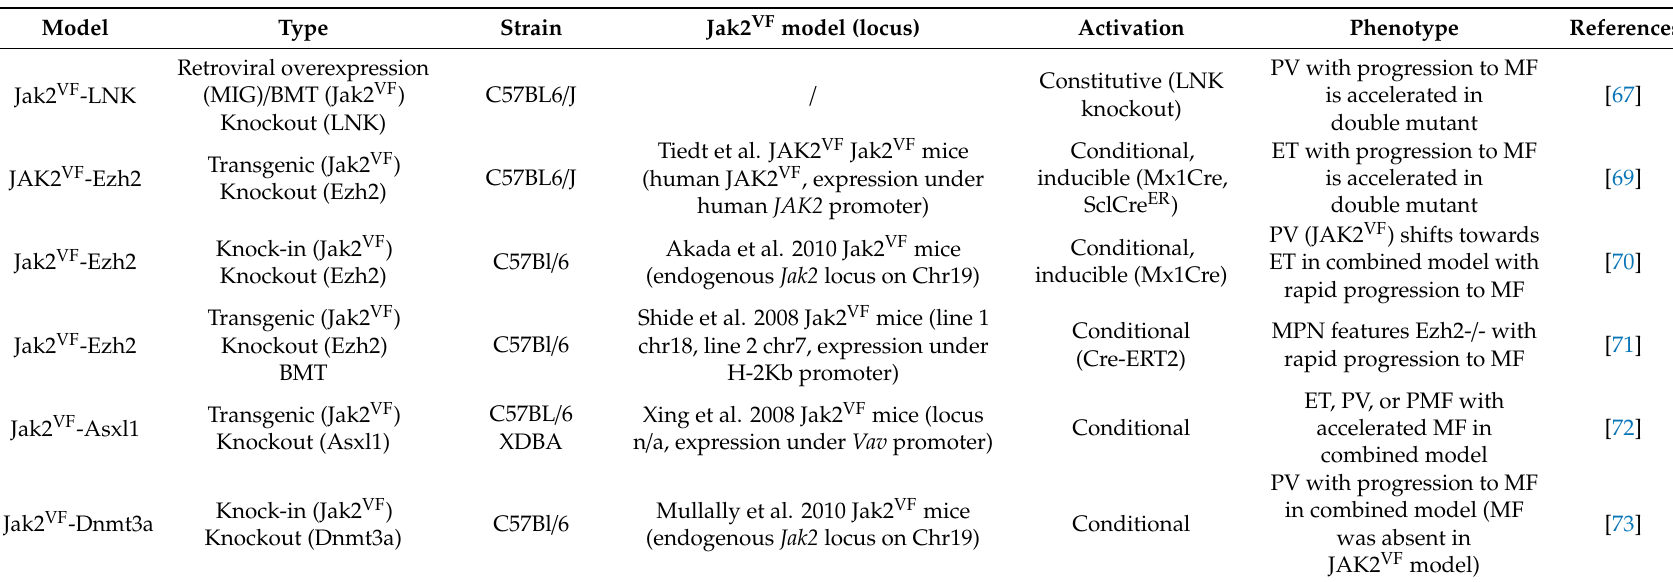
Table 3. Mouse models of myelofibrosis targeting multiple genes. BMT: bone marrow transplant, ET: essential thrombocythemia, MF: myelofibrosis, PMF: primary myelofibrosis, TPO: thrombopoietin, PV: polycythemia